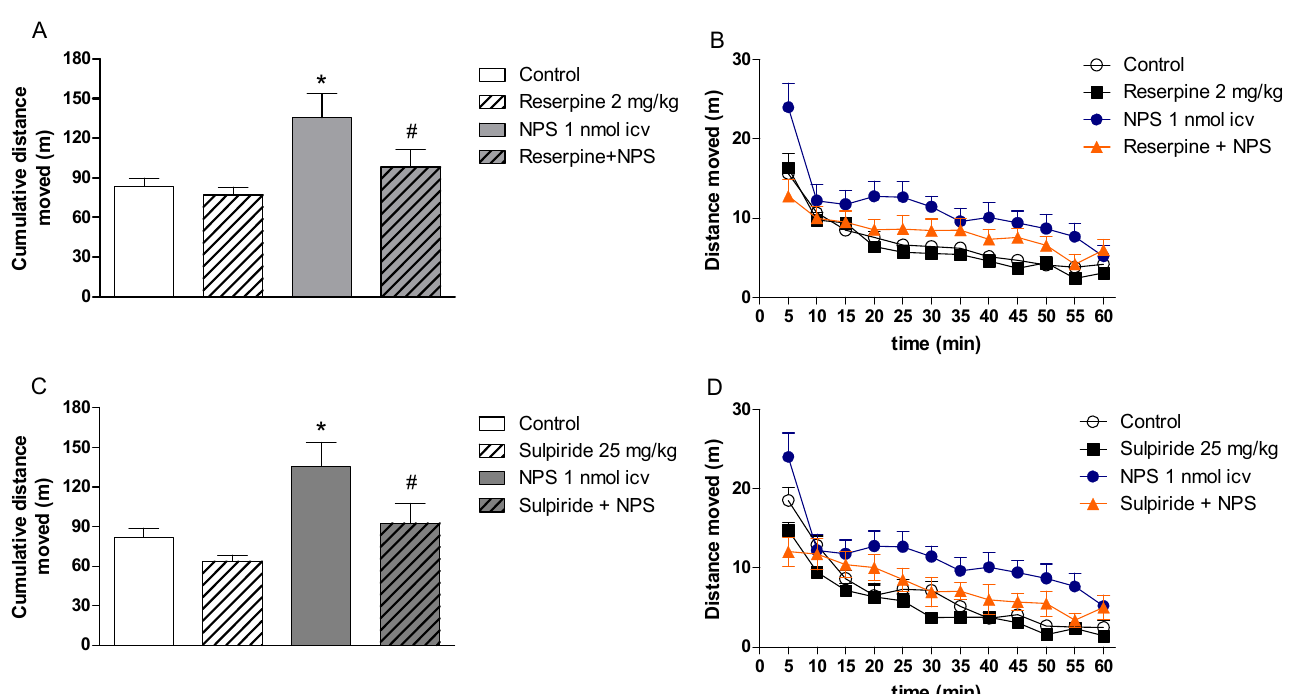
Figure 1. The hyperlocomotor effects of Neuropeptide S (NPS) are impaired in mice pretreated with drugs able to block dopaminergic transmission. Pretreatment with ( A , B ) reserpine 2 mg/kg (sc, 24 h before NPS), an inhibitor of vesicular uptake of catecholamines and 5-HT, and ( C , D ) sulpiride 25 mg/kg (ip, 45 min before NPS), a D 2 -like receptor antagonist, prevented the hyperlocomotor effects of NPS 1 nmol (icv, 15 min prior to the test) in male Swiss mice assessed in the open field (40 × 40 × 40 cm) test for 60 min. Data are presented as cumulative distance moved (m) and distance moved (m) in blocks of 5 min. * p < 0.05 vs. Control; # p < 0.05 vs. NPS. ANOVA, Dunnett’s post hoc test (( A ); F (3,50) = 8.46; p < 0.05; ( C ); F (3,43) = 9.93; p <